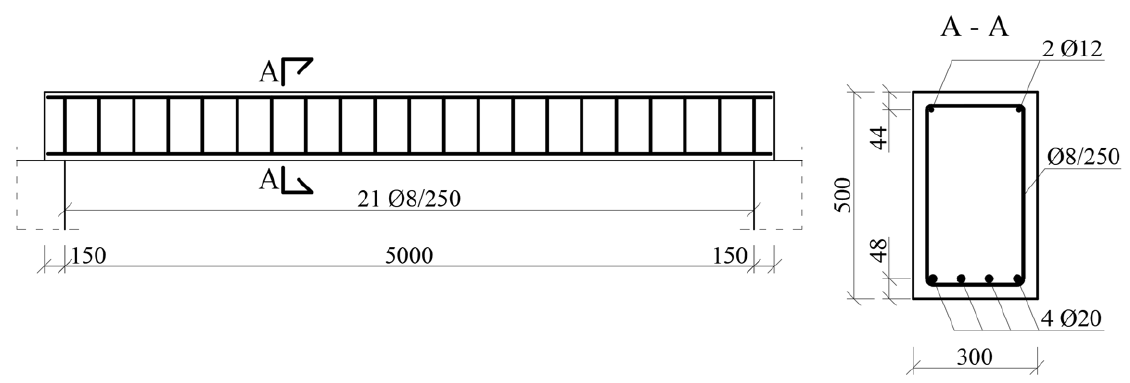
Figure 13: View and cross section of the considered beam (all dimensions in